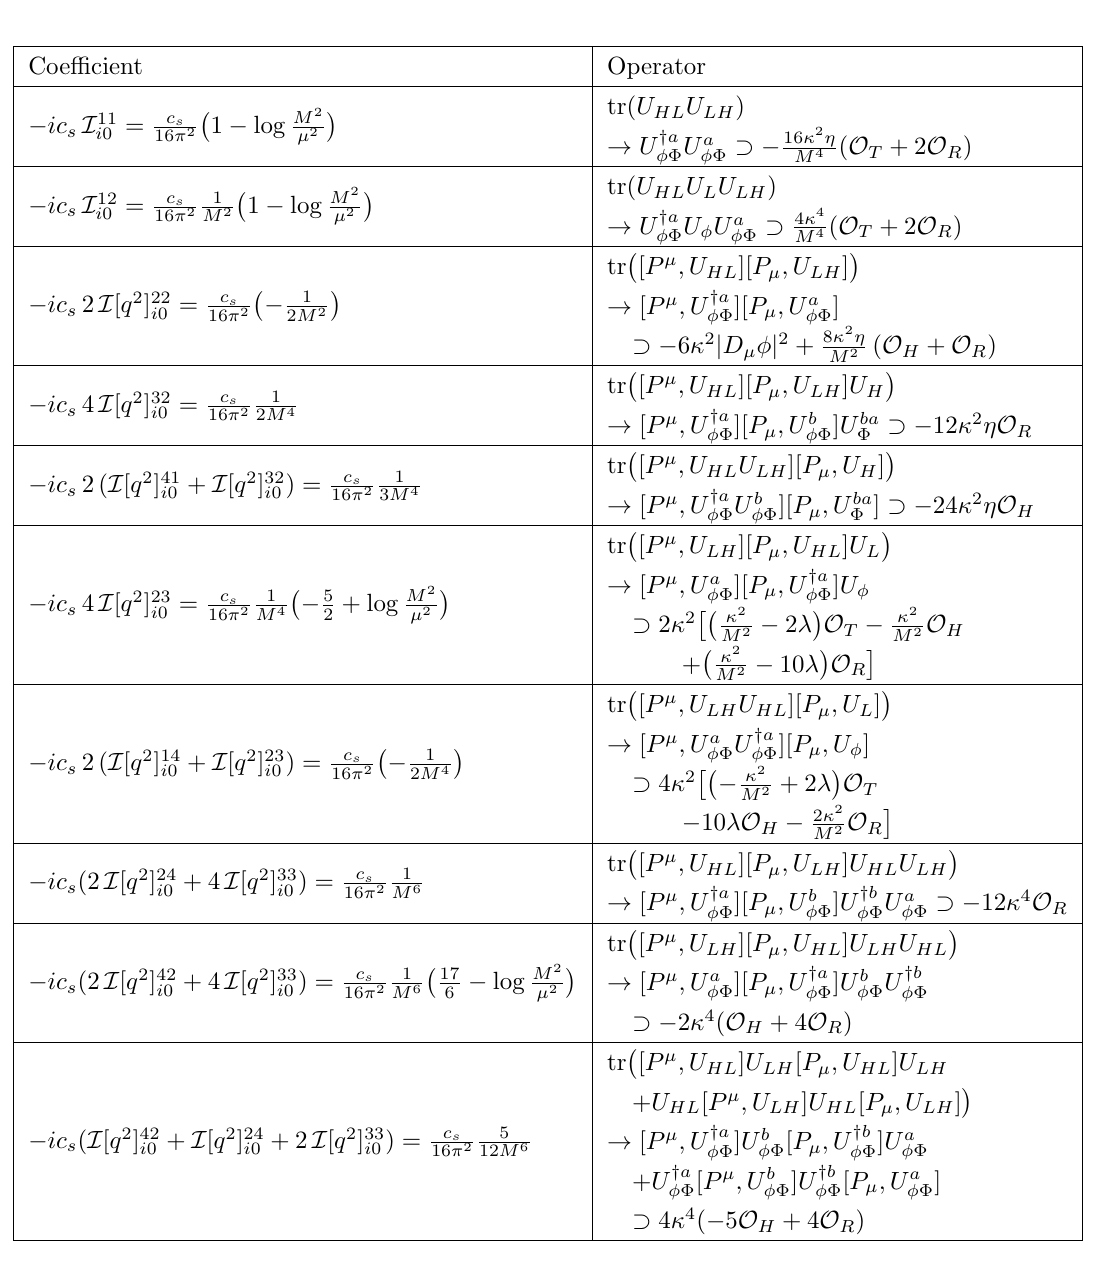
Table 6 . Summary of the results in eq. (4.29) for mixed heavy-light contributions to one-loop matching for the scalar triplet model. The SM gauge coupling-independent terms for the